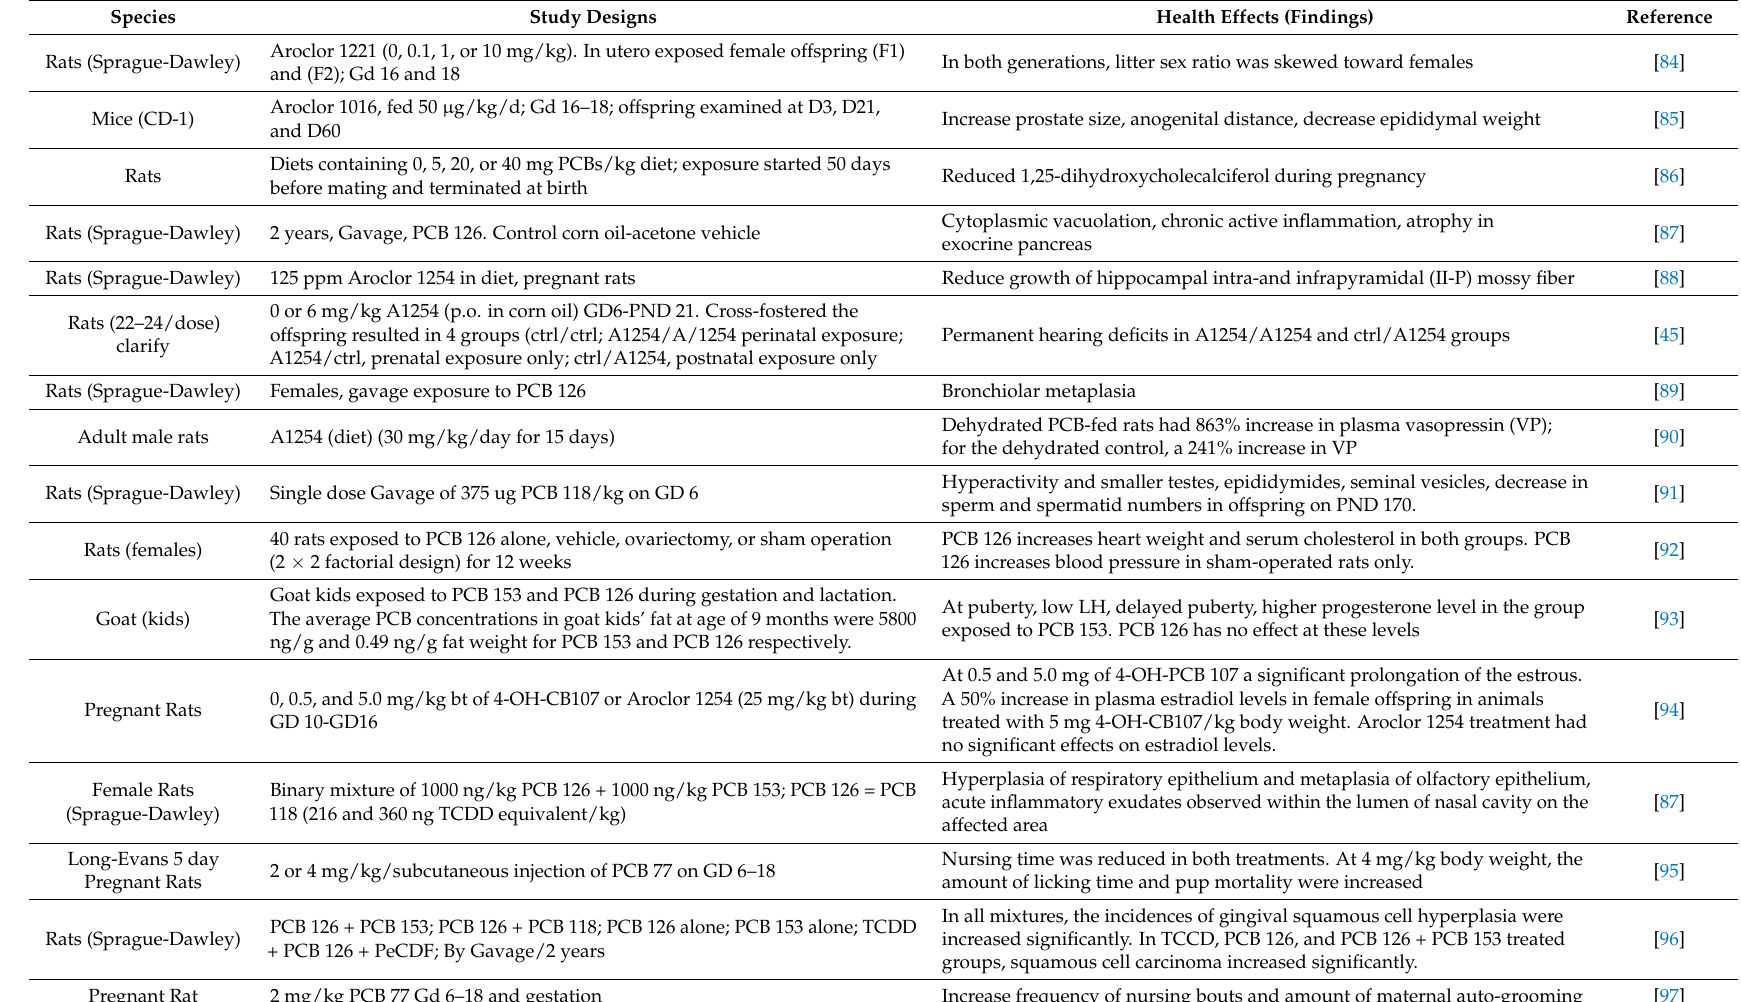
Table 3. Summary of health effects in animal studies on exposure to PCBs [9]. Copyright PMC